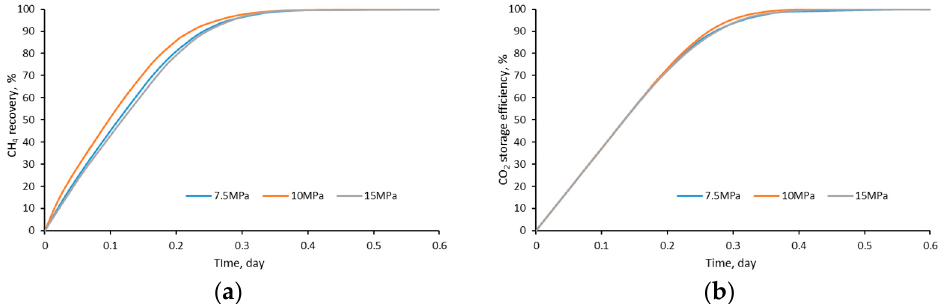
Figure 20. The variation curves under different pressures. ( a ) CH 4 recovery; ( b ) CO 2 storage effi- ciency.